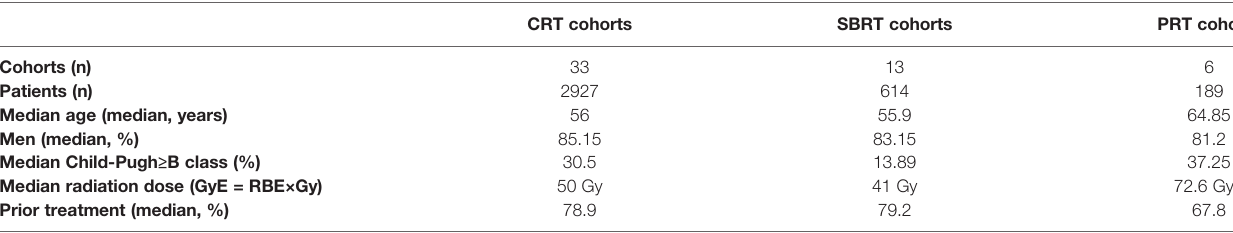
TABLE 2 | Baseline characteristics of CRT, SBRT and PRT